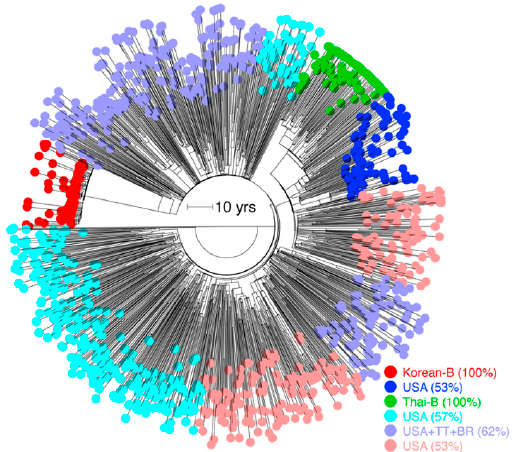
Figure 5. Hidden population structure in time-scaled subtype B tree. Identified partitions are colored individually. Partitions are named by the country or group of countries with >50% sequences in that